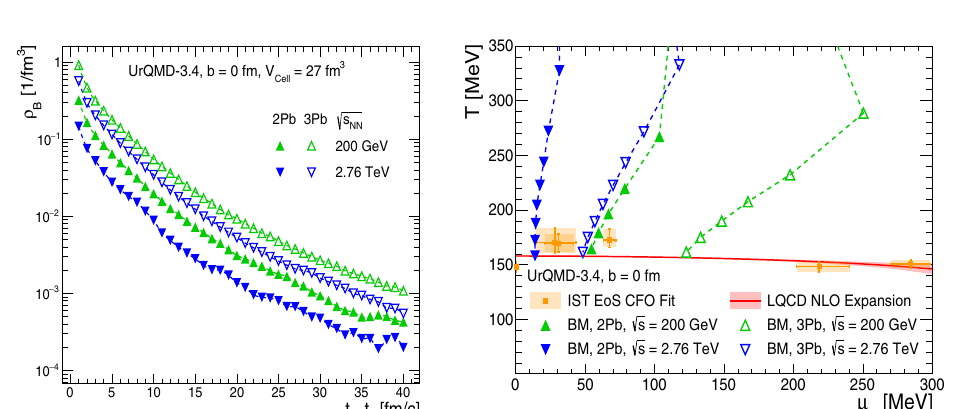
Figure 2. Left panel: The time evolution of the baryonic charge density in the central cell during the process expected for the most central and Figure 1. Left panel: The ratio of hadronic yields per rapidity unit dN of ordinary BNC (filled symbols) and for the TNC (empty symbols) found for √ s NN = 200 GeV (squares) and d y simultaneous Pb + Pb + Pb TNC to the one for the most central Pb + Pb collisions (i.e. 3-to-2 nuclei enhancement for √ s NN = 2 . 76 TeV (circles). The time t 0 is the moment, when the remnants of projectile nuclei have passed factor for yields) for the collision energy √ s NN = 200 GeV. Right panel: Ratio of transversal momentum spectra through the central cell. Right panel: The evolution of central cell parameters in the µ B of the most central and simultaneous Pb + Pb + Pb TNC to the one found for the most central Pb + Pb collisions (3- the MIT Bag Model equation of state [12]. The filled symbols correspond to the Pb + Pb collisions, while the to-2 nuclei enhancement factor for p T spectra) of hadrons obtained for the same collision energy √ s NN = 200 empty ones to the Pb + Pb + Pb TNC. Collision energy √ s NN = 200 GeV ( √ s NN = 2 . 76 TeV) points are shown by y < 0 . 1. GeV as a function of particle transverse momentum found at the triangles up (down). The topmost points correspond to the time t | | temperature corresponds to a lattice QCD parameterization [13], while the crosses correspond to the chemical freeze-out parameters in Pb + Pb collisions found in Ref.